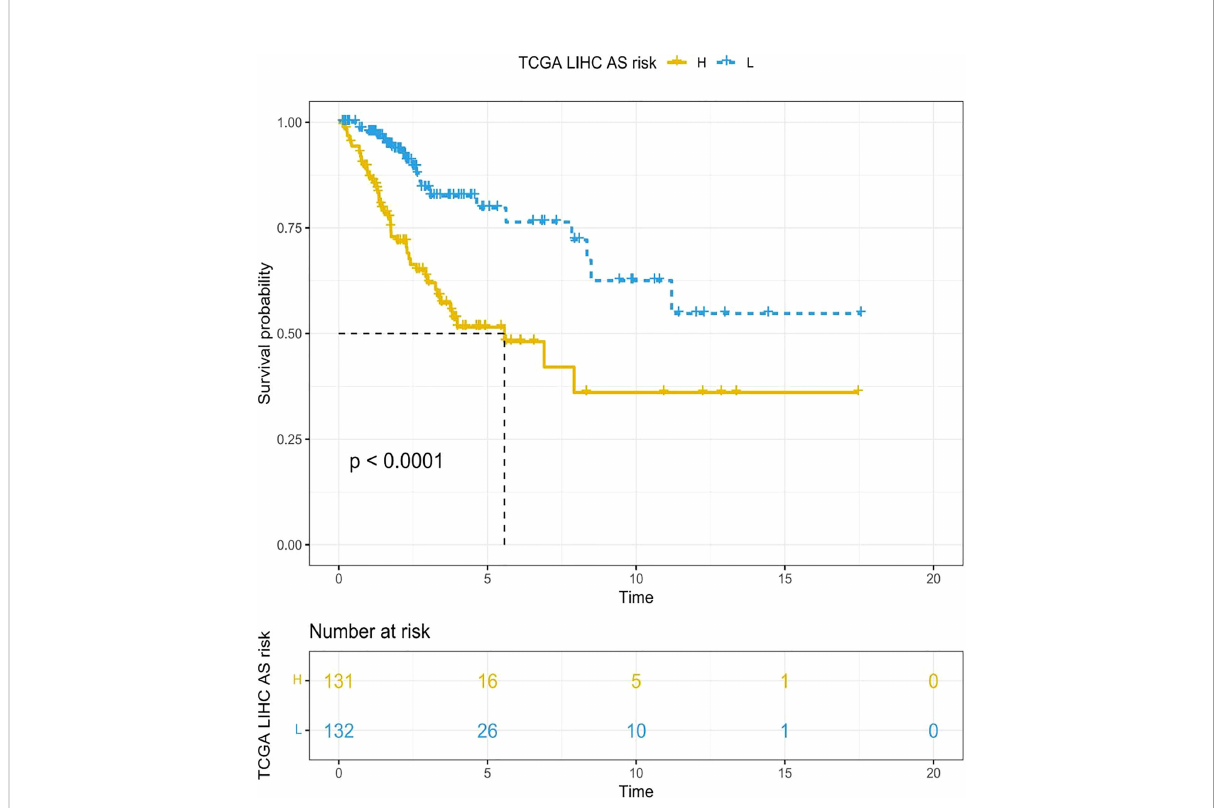
FIGURE 2 The Kaplan – Meier survival curves depicting the risk scores of the three ARLs. In comparison with the low-risk group, the group with higher risk scores had shorter OS ( p < 0.001, log-rank